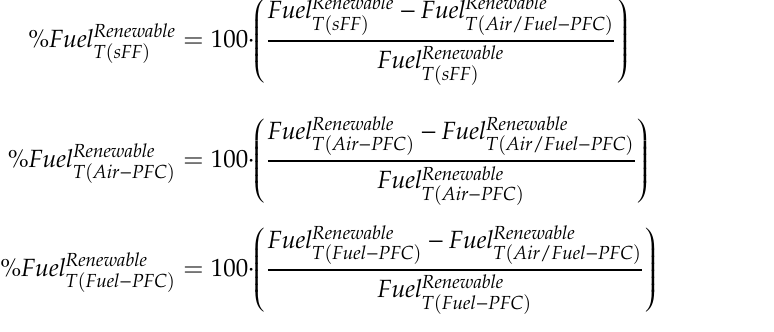
Table 4. Fuel economy of FC / renewable HPS using the strategy air / fuel-PFC compared to the strategies sFF, air-PFC, and fuel-PFC.